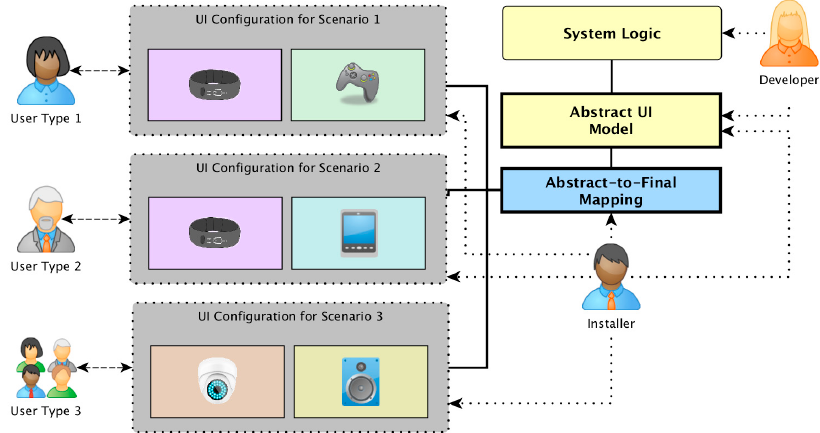
Figure 6. Many different UIs can be deployed for the same Abstract UI definition and the same UI Control Logic. The installer of the system only has to specify different mappings for each scenario.